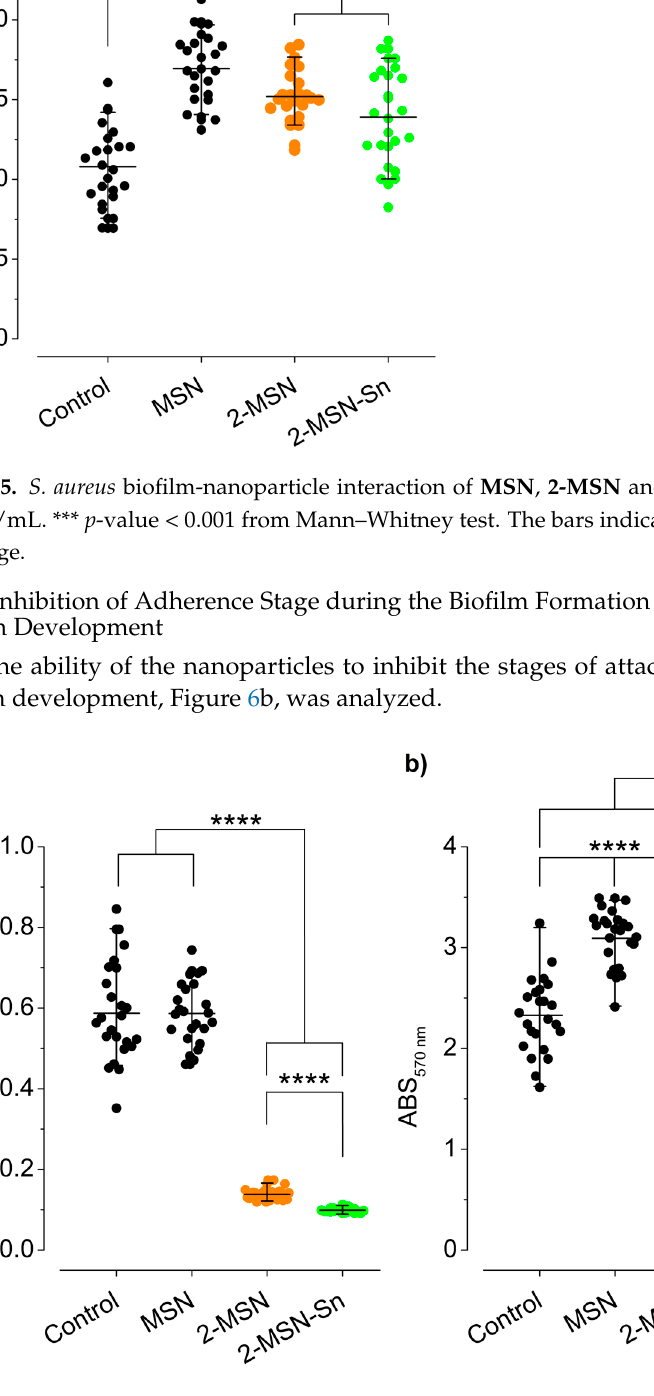
Figure 6. Inhibition of ( a ) attachment and ( b ) biofilm development of MSN , 2-MSN and 2-MSN-Sn materials at 250 μ g/mL. **** p -value < 0.0001 from Mann–Whitney tests. The bars indicate median and interquartile range.